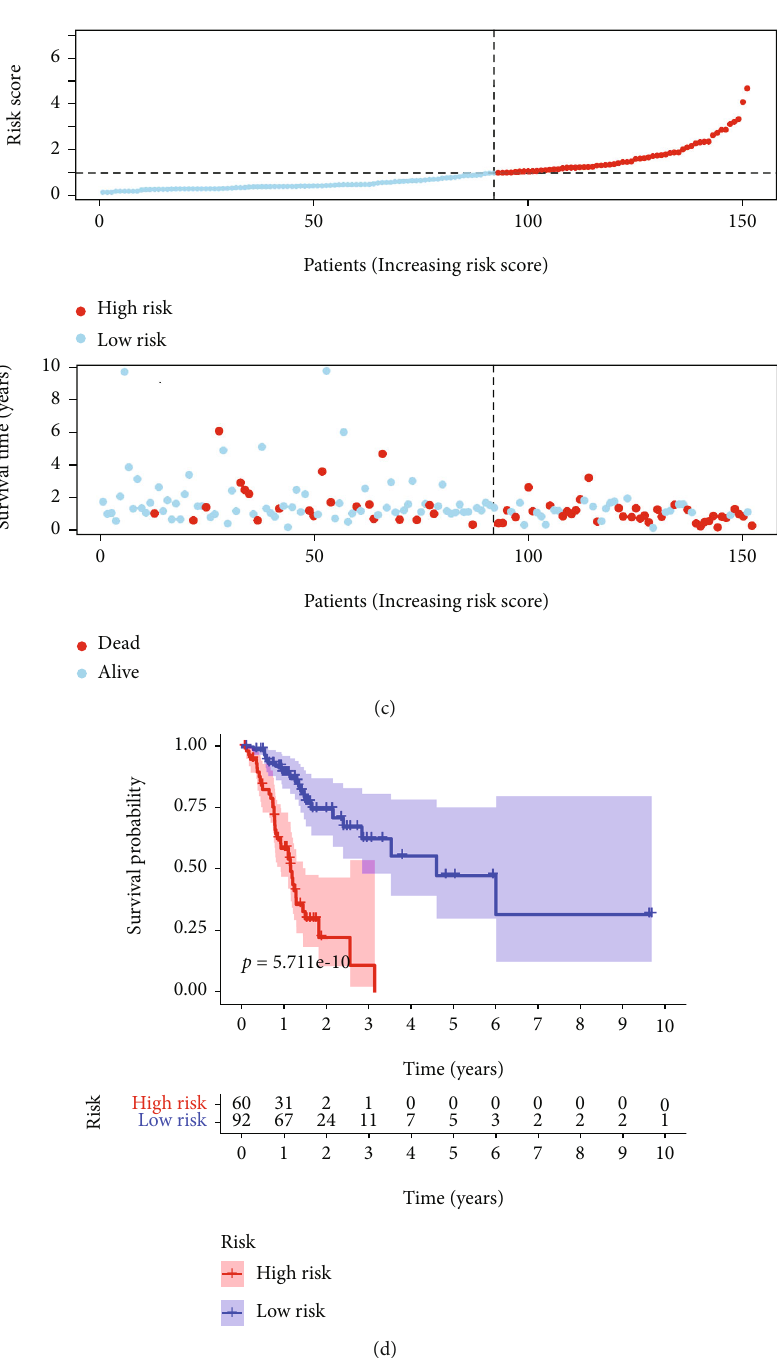
Figure 6: Prognosis prediction of the model in two validation sets. The survival status of the patients in validation set 1 and validation set 2 ((a) and (c)). Kaplan Meier was used to visualize survival probability of the patients in two validation sets ((b) and